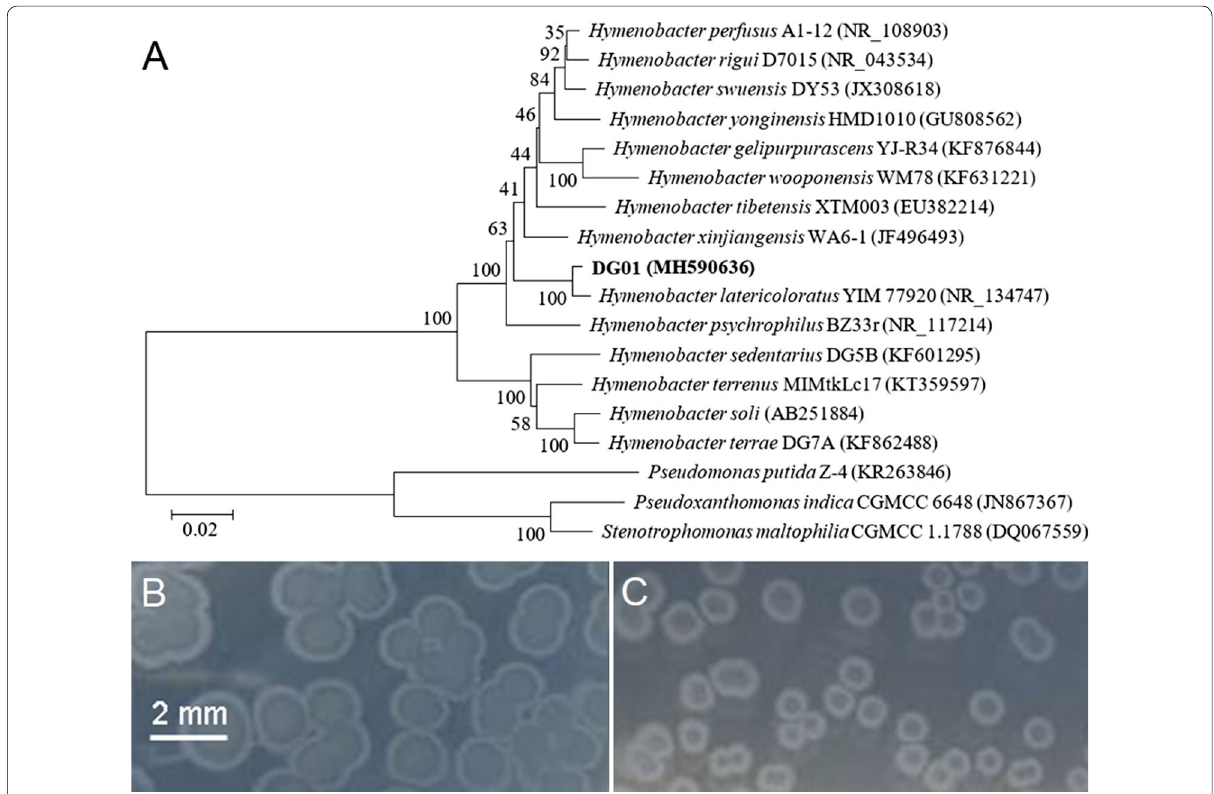
Fig. 2 Neighbor-joining phylogenetic tree based on 16S rRNA gene sequences showing the phylogenetic relationship between strain DG01 and closely related taxa ( a ). The bar represents 0.02 substitutions per nucleotide position. Bootstrap values (expressed as percentages of 1000 replications) are shown at the branch points. The imidacloprid-degrading bacteria Pseudoxanthomonas indica CGMCC 6648 and Stenotrophomonas maltophilia CGMCC 1.1788 were used outgroups. Colonies of Hymenobacter latericoloratus CGMCC 16346 grown on 1/1000th ( b ) and 1/10000th lysogeny broth (LB) 2% agar plates ( c ). No bacterial colony was observed on the control plate containing agar